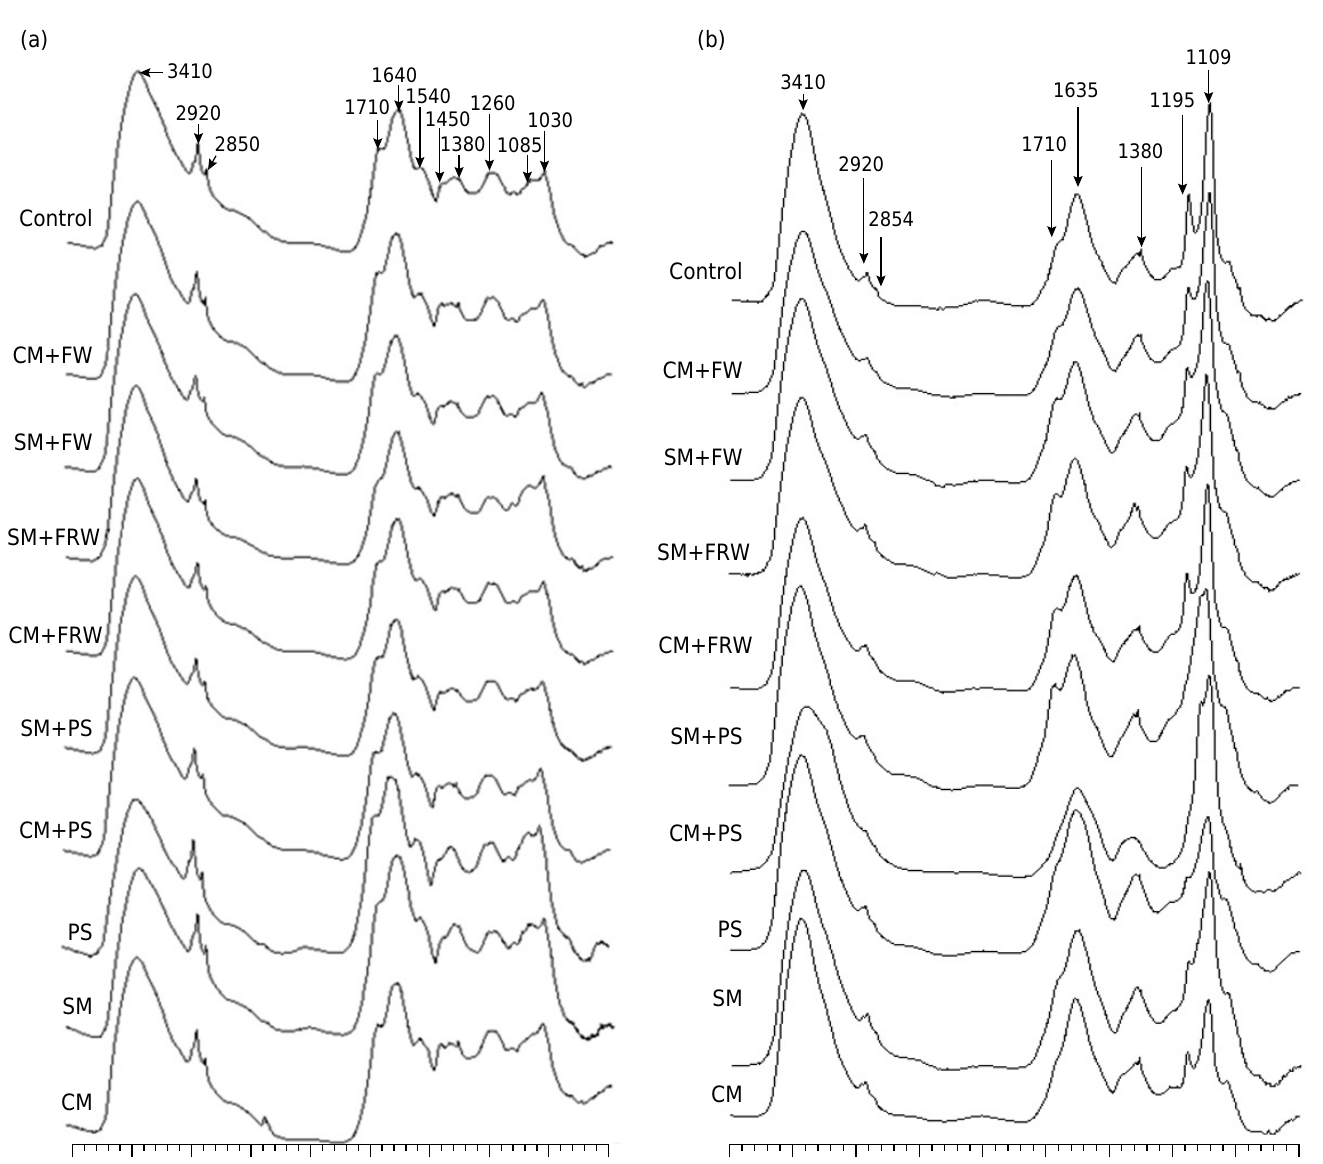
Figure 2. Fourier-transform infrared spectroscopy of humic acids (a) and fulvic acids (>1 kDa) (b) extracted from an Acrisol amended with vermicomposts. Control = without vermicompost; CM = cattle manure; SM = sheep manure; PS = rice parboiling sludge; CM+PS = cattle manure + rice parboiling sludge; SM+PS = sheep manure + rice parboiling sludge; CM+FW = cattle manure + food waste; SM+FW = sheep manure + food waste; CM+FRW = cattle manure + fruit waste; and SM+FRW = sheep manure + fruit waste. Mixture of vermicomposts was performed in 1 : 1